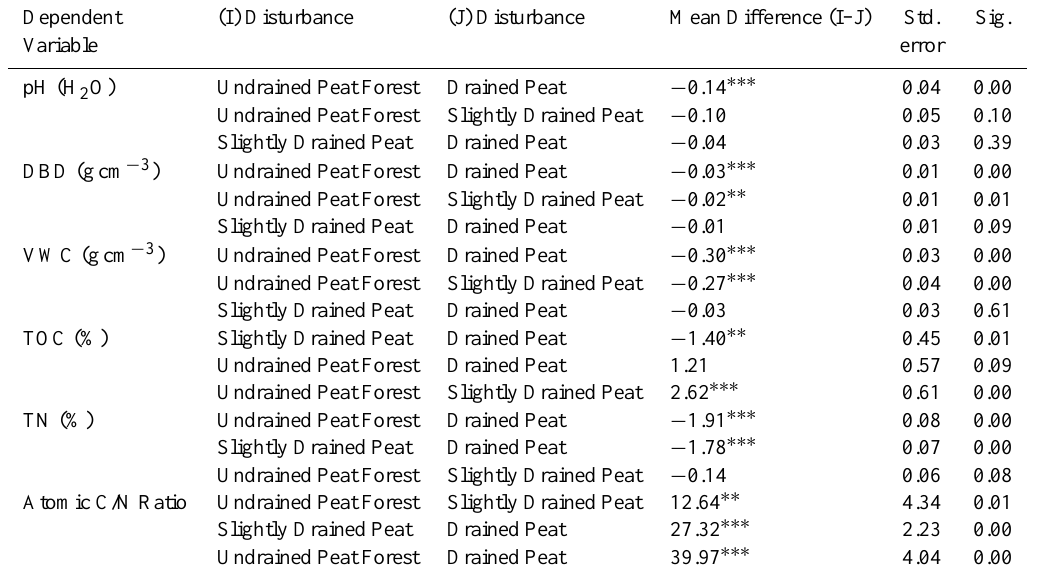
Table 11. Games-Howell (GH) Multilple Comparisons of Drainage Groups.